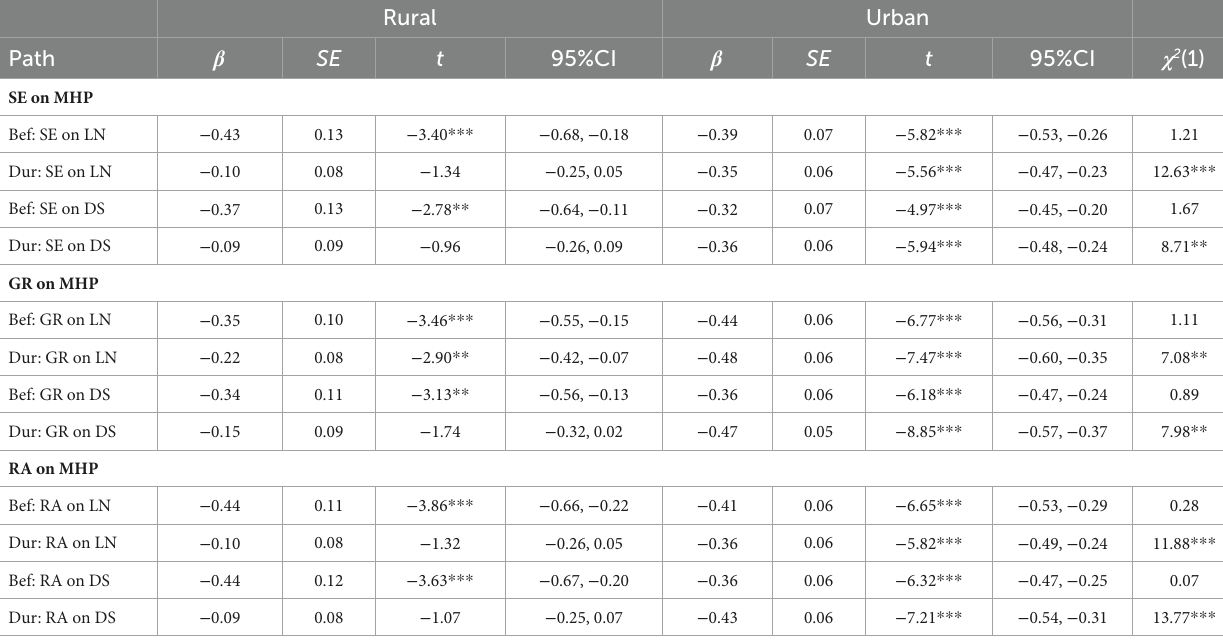
TABLE 7 Rural-group differences in the relations of group orientations on mental health problems before and during the pandemic. Rural